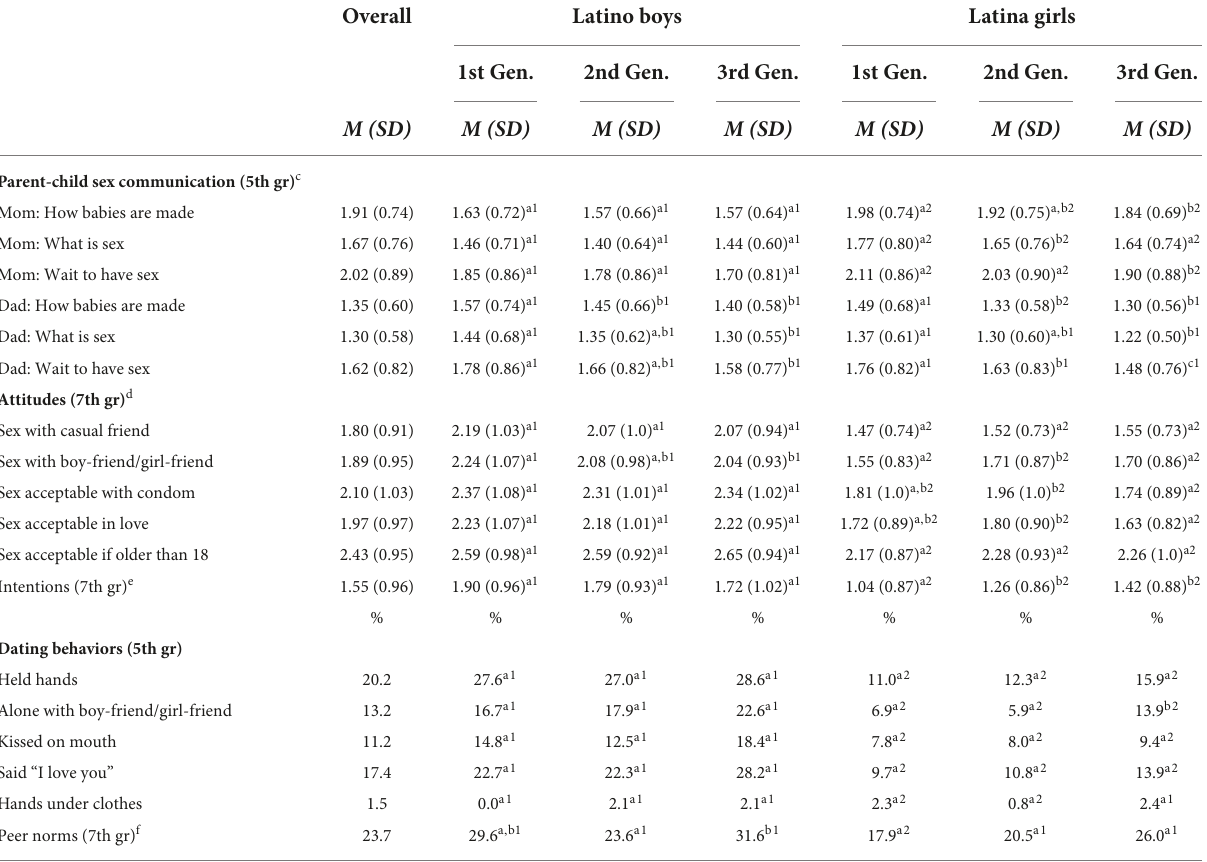
TABLE 1 Descriptive characteristics for the overall sample ( N = 1,764) and by gender and generational status. Overall Latino boys Latina girls 1st Gen. 2nd Gen. 3rd Gen. 1st Gen. 2nd Gen. 3rd Gen.